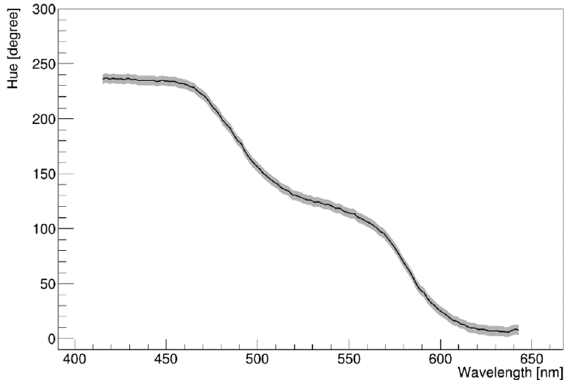
Figure 8. H-W curve obtained with Canon EOS D450 using the CFA technology for the wavelengths from 400 to 650 nm. The response of the CMOS camera is not sensitive outside this wavelength region. A monotonic decrease can be seen, and a non-linear H-W relationship is evident. The gray band represents an unavoidable uncertainty due to the beam size and doubled exposure time. In addition, the effect of reflection or dispersion on the screen also needed to be considered. The uncertainty in H was determined by standard deviation on the H distribution for a 2 nm scale wavelength.